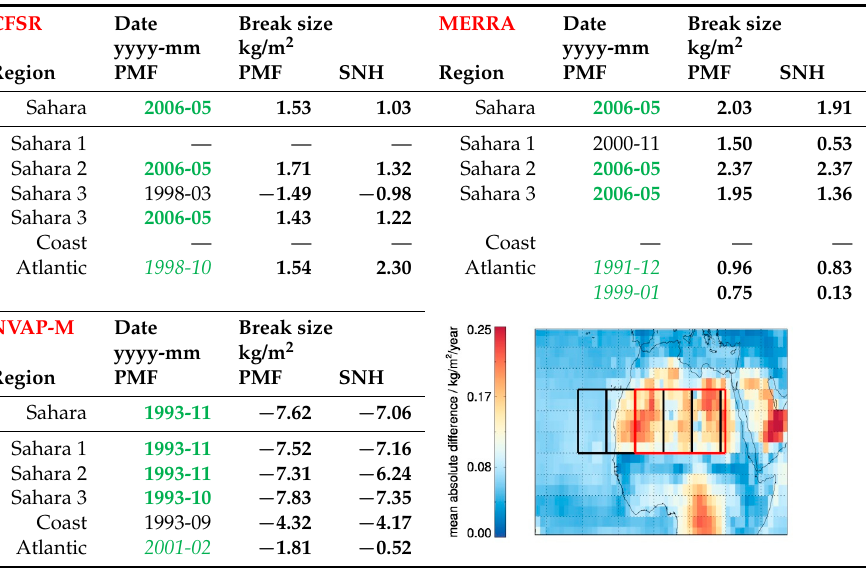
Table 3. Dates of confirmed break points and break sizes from the PMF and the SNH test for the region Sahara and for five additional regions which are shown in the figure to the lower right. The results are based on the analysis of TCWV anomaly differences relative to ERA-Interim. Printed in bold and green are break points that are observed over Sahara and its three subregions and printed in italic and green are break points over the Atlantic which are different from the break points over Sahara. The figure is a zoom into the right panel of Figure 2. Marked in red is the region Sahara and marked in black are the five subregions: Sahara 1, Sahara 2, Sahara 3, Coast and Atlantic (from east to west). Each subregion has identical width and length in degrees latitude and